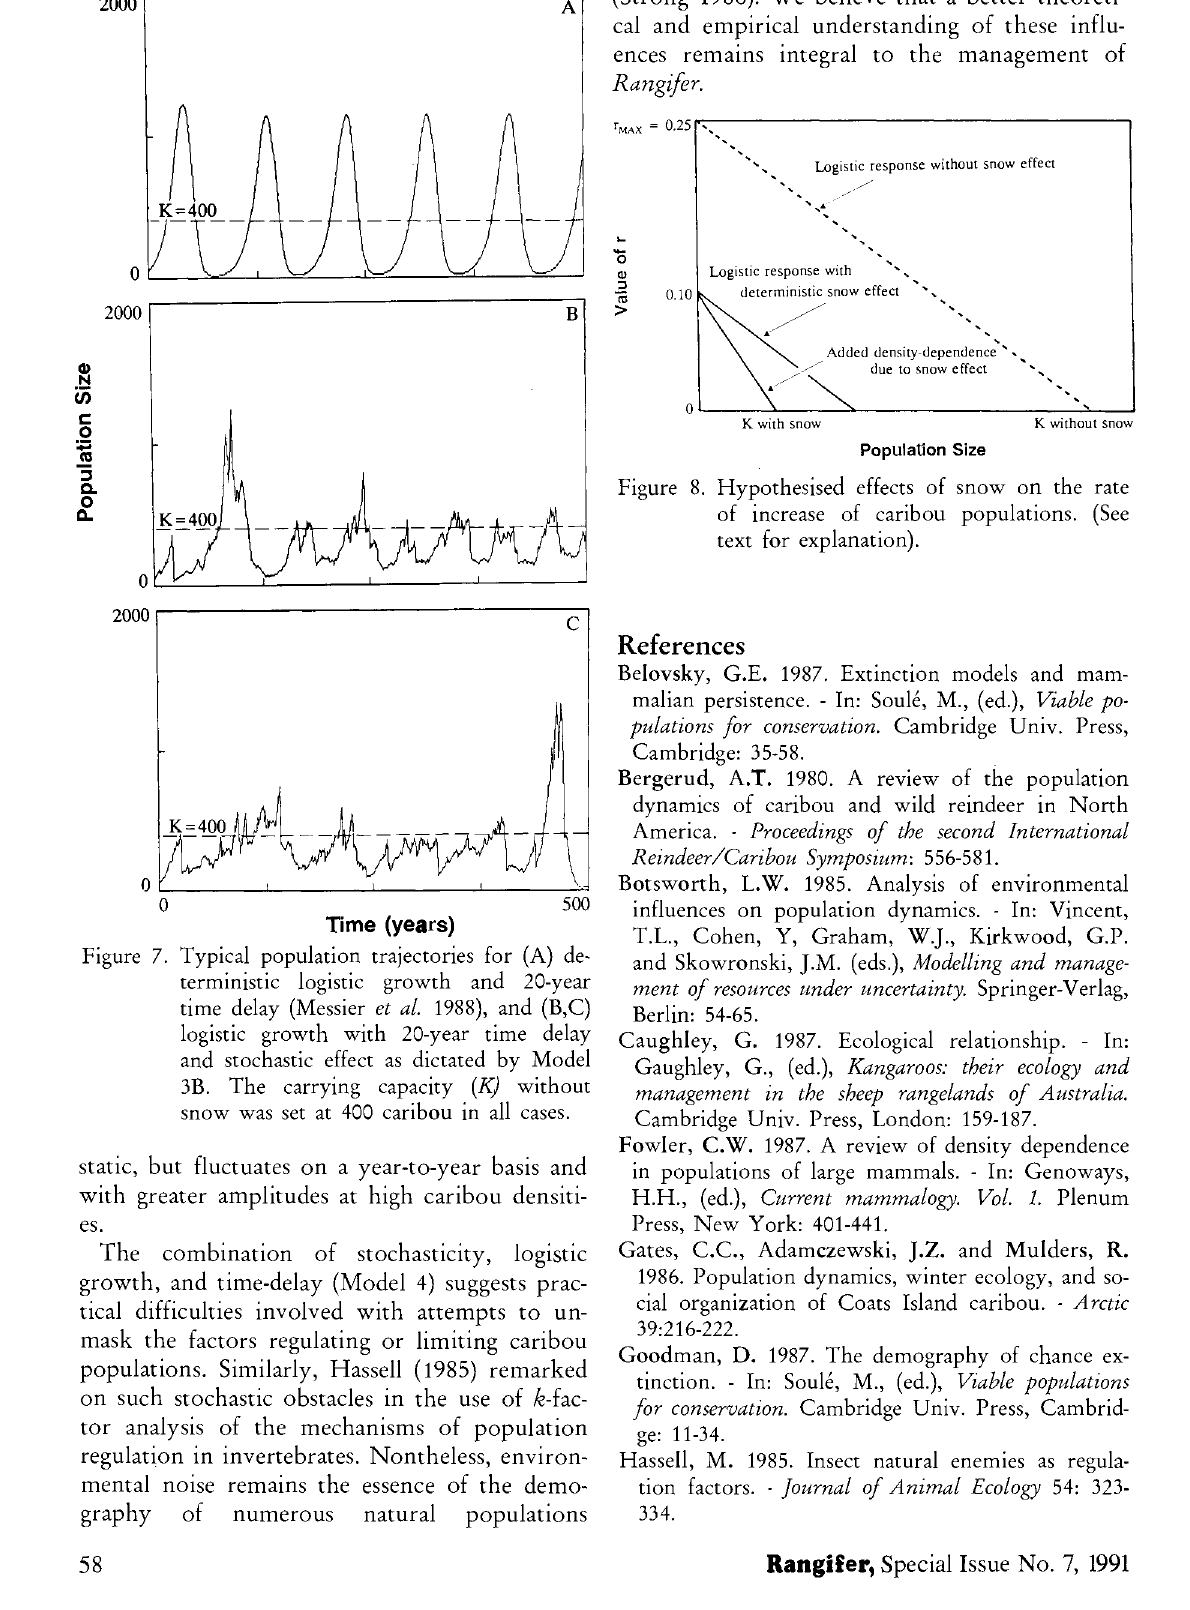
Figure 8. Hypothesised effects of snow on the rate of increase of caribou populations. (See text for